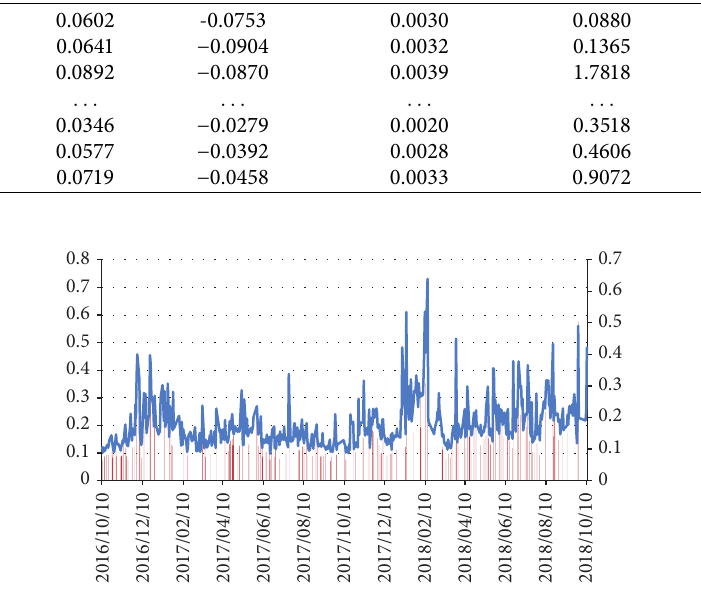
Figure 2: Realized volatility and realized jump of 601857.SH. Table 2: Statistical properties of realized volatility for some energy stocks.